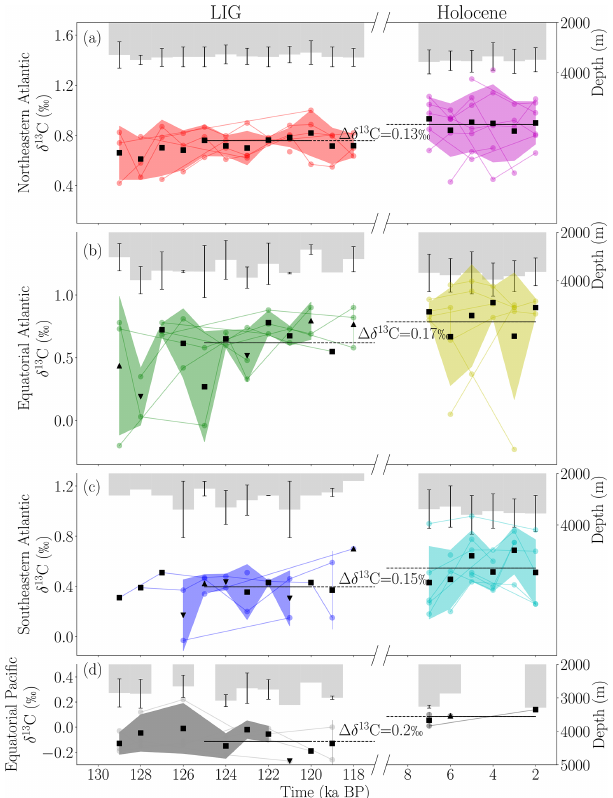
Figure 4. Benthic foraminifera δ 13 C (left y axis, ‰) during the LIG (left) and Holocene (right) for four defined regions: northeastern Atlantic (a) , equatorial Atlantic (b) , southeastern Atlantic (c) , and eastern equatorial Pacific (d) . Data are presented in discrete time slices spanning 1kyr. Only cores deeper than 2500m are shown. Circular, coloured points connected by lines show each average δ 13 C value per core per time slice. Black symbols represent δ 13 C averages per slice. Each slice has a corresponding averaged depth (right y axis, m), with 1 standard deviation on either side shown on the bars. Slices with an average depth within ± 300m of the mean core depth of all slices are represented with a square point. Slices with an average depth 300m shallower than the mean are shown with an upward triangle, and slices that are than 300m deeper than the mean are shown with a downward triangle. Shading shows 1 standard deviation on either side of the mean for slices where more than one point